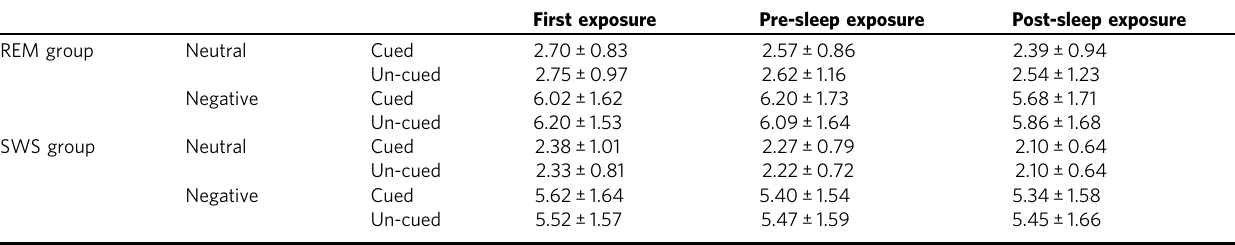
Table 1 Average subjective arousal ratings at each session.